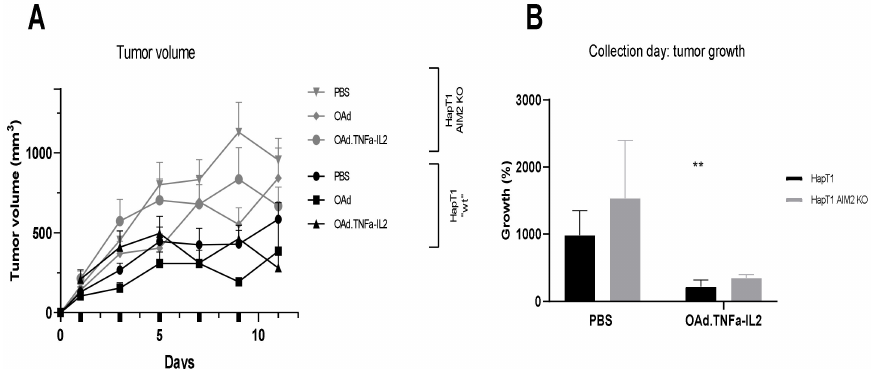
Figure 4. In vivo assessment of AIM2 knockout (KO) e ff ect on tumor growth: Syrian hamster subcutaneous HapT1 or HapT1 AIM2 − / − tumors were treated every other day (treatment days indicated as bold ticks on x-axis) with indicated viruses or control until collection of samples on day 11 of the experiment. ( A ) Tumor growth measured in volume. ( B ) Percentual growth of tumors on experiment day 11 compared to the size on experiment day 1: Statistical analysis was conducted compared to PBS treated, “wt” HapT1 tumors by Kruskal–Wallis test; mean + SEM are shown, ** p <